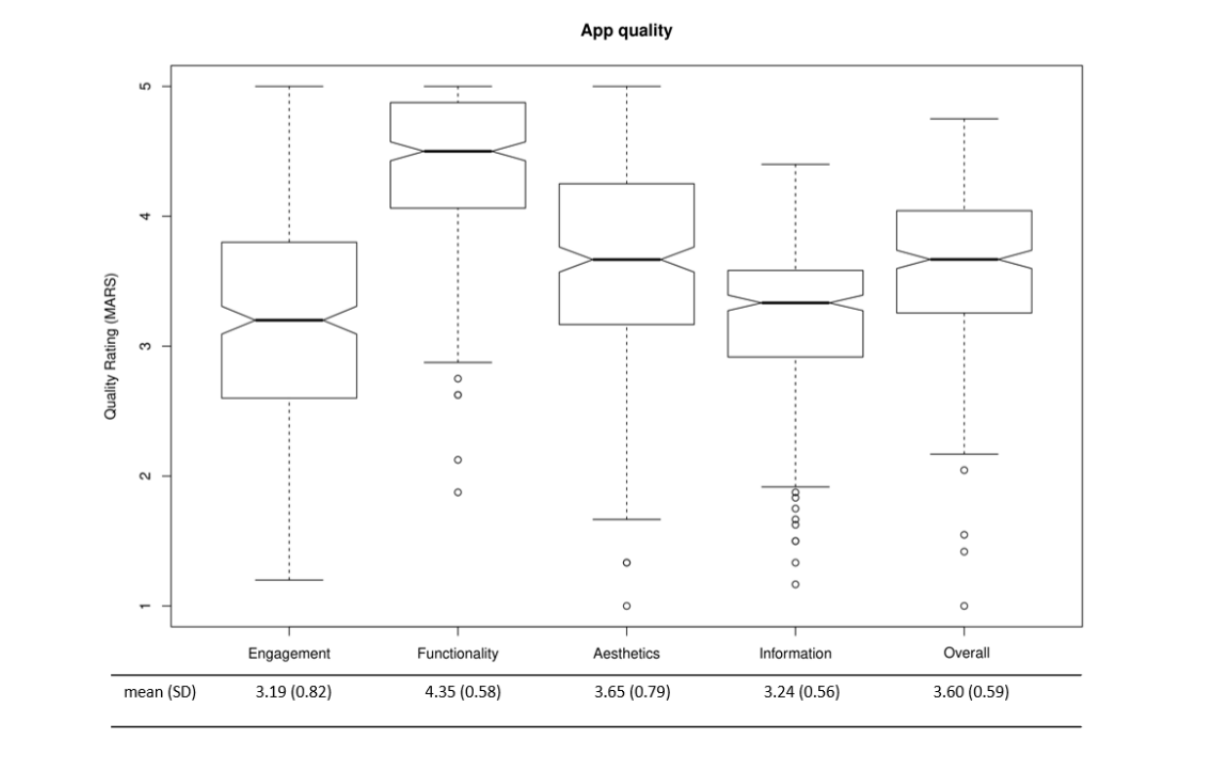
Figure 3. Quality of the apps. MARS: Mobile App Rating Scale.